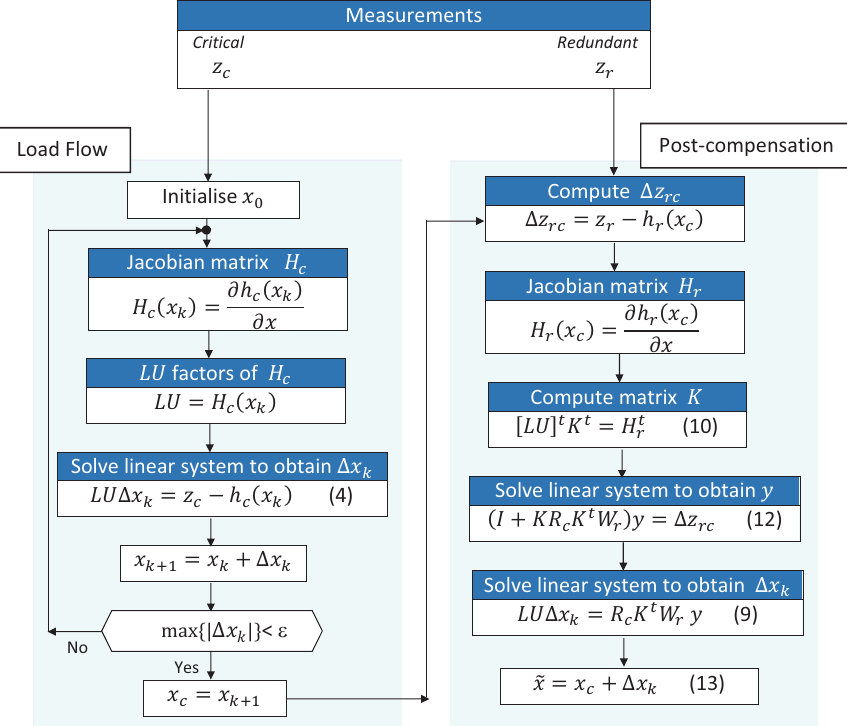
Figure 2. Flow diagram of the proposed